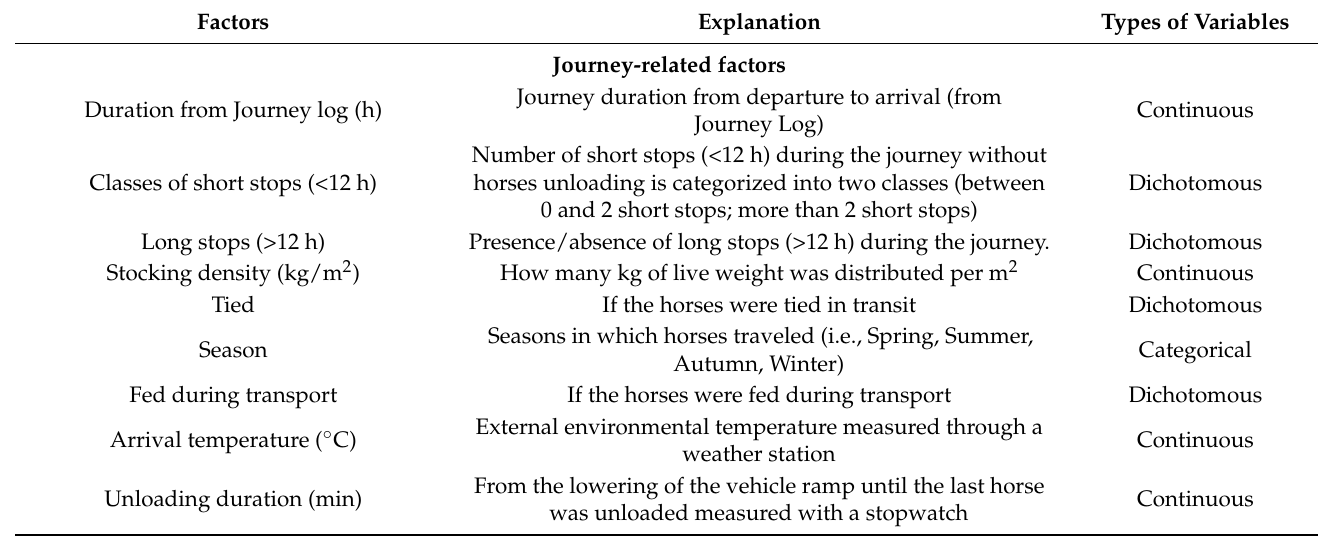
Table 2. Meaning and types of factors collected and included as factors in the subsequent statistical